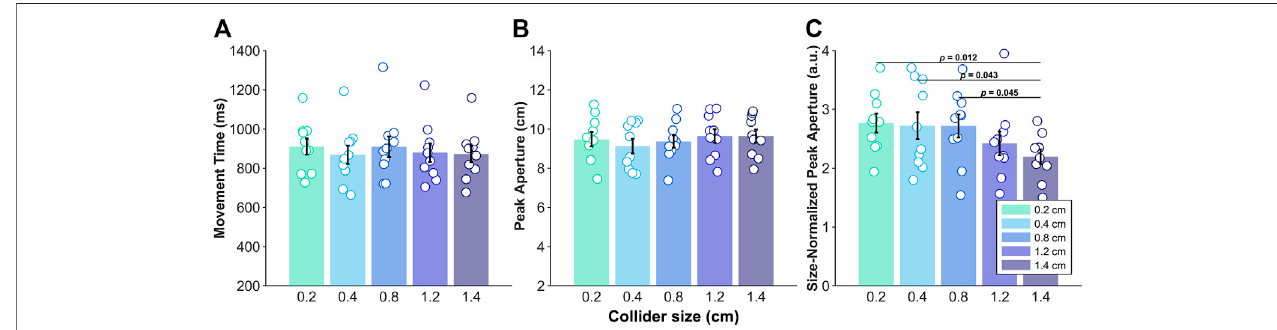
FIGURE6 | Study 2. Effects ofcollider size on (A) movementtime, (B) peak aperture, and (C) size-normalized peak aperture. Errorbars indicate ± 1 SEM ( n (cid:1) 10). Data calculated across all levels of object size and object distance for each participant.